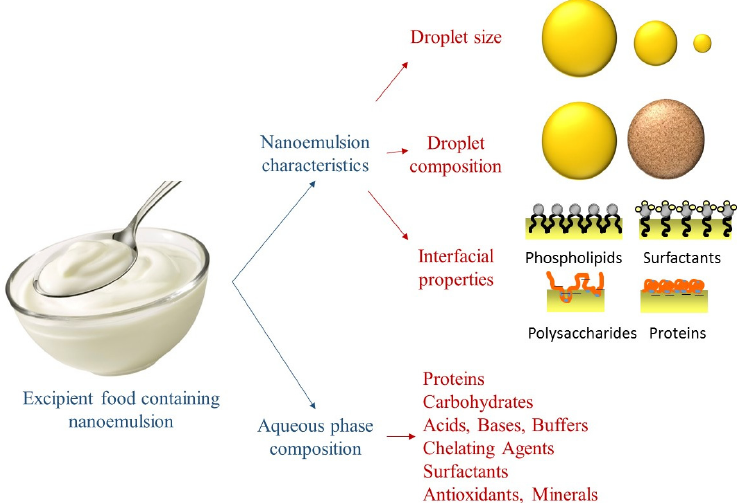
Figure 3. Schematic representation of the variables that can be modulated in order to formulate excipient nanoemulsions to enhance the oral bioavailability of naturally-occurring bioactive